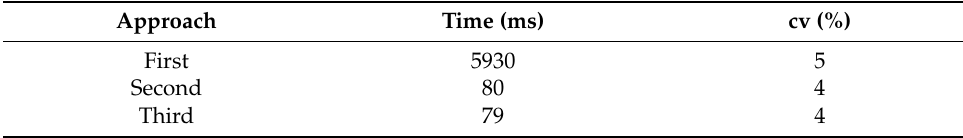
Table 10. State recreation, execution time r =